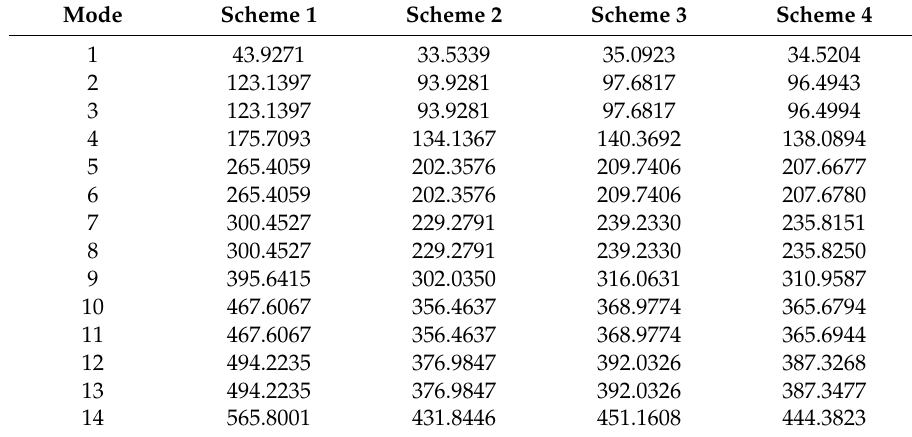
Table 6. First fourteen natural frequencies (Hz) of a simply-supported thin plate for several through-the-thickness distributions of the reinforcing fibers.